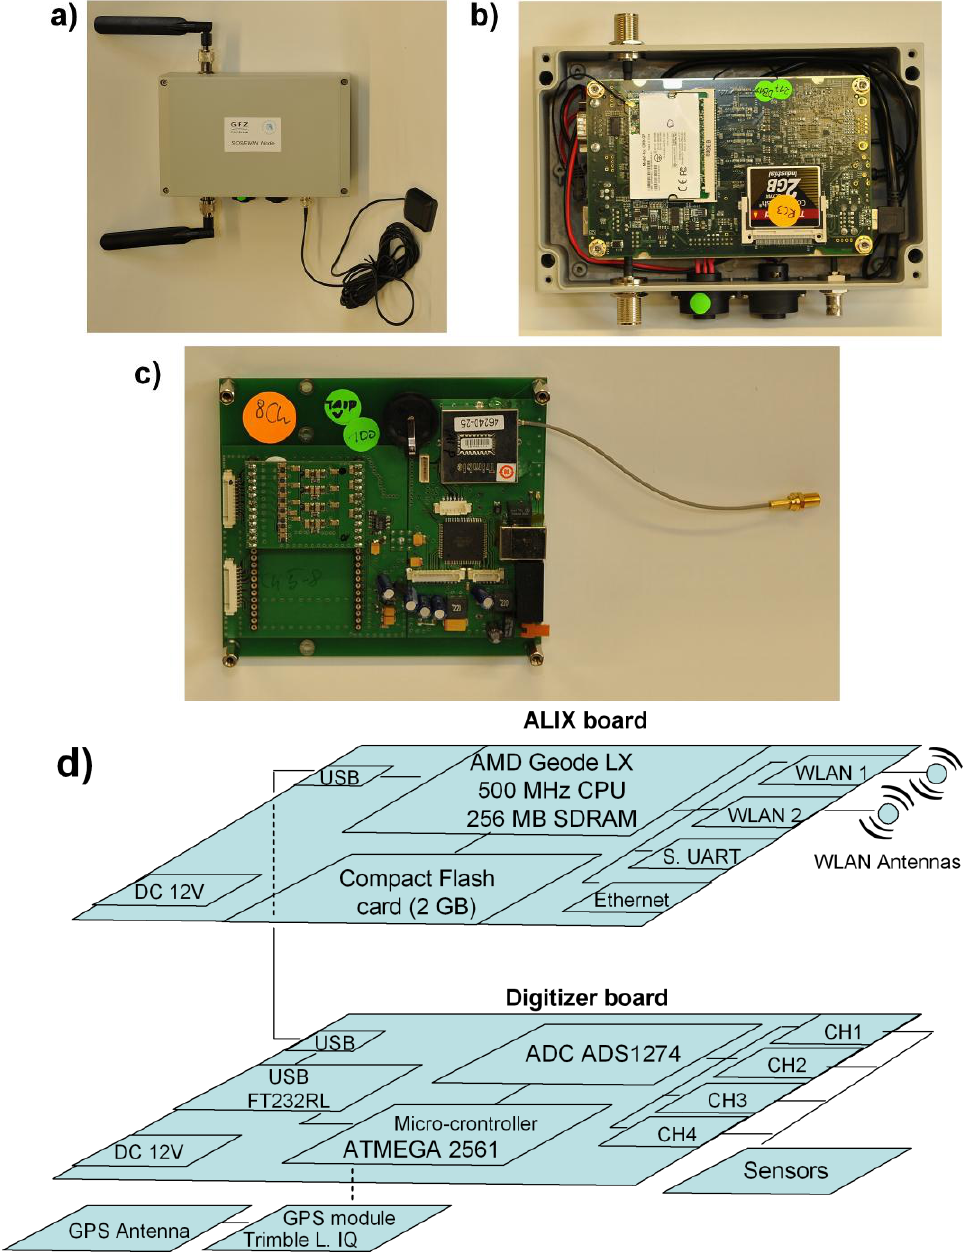
Figure 2. The prototype GFZ Wireless Sensing Unit (GFZ-WSU). (a) The complete unit. (b) The WRAP board. (c) The ADC board. (d) A schematic overview of the architecture